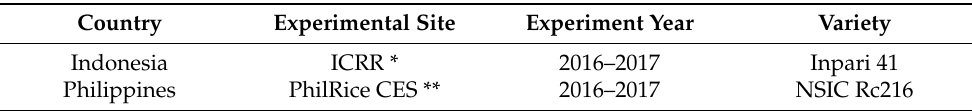
Table 3. On-station field experiments conducted at different research stations for crop data file prepa- ration.